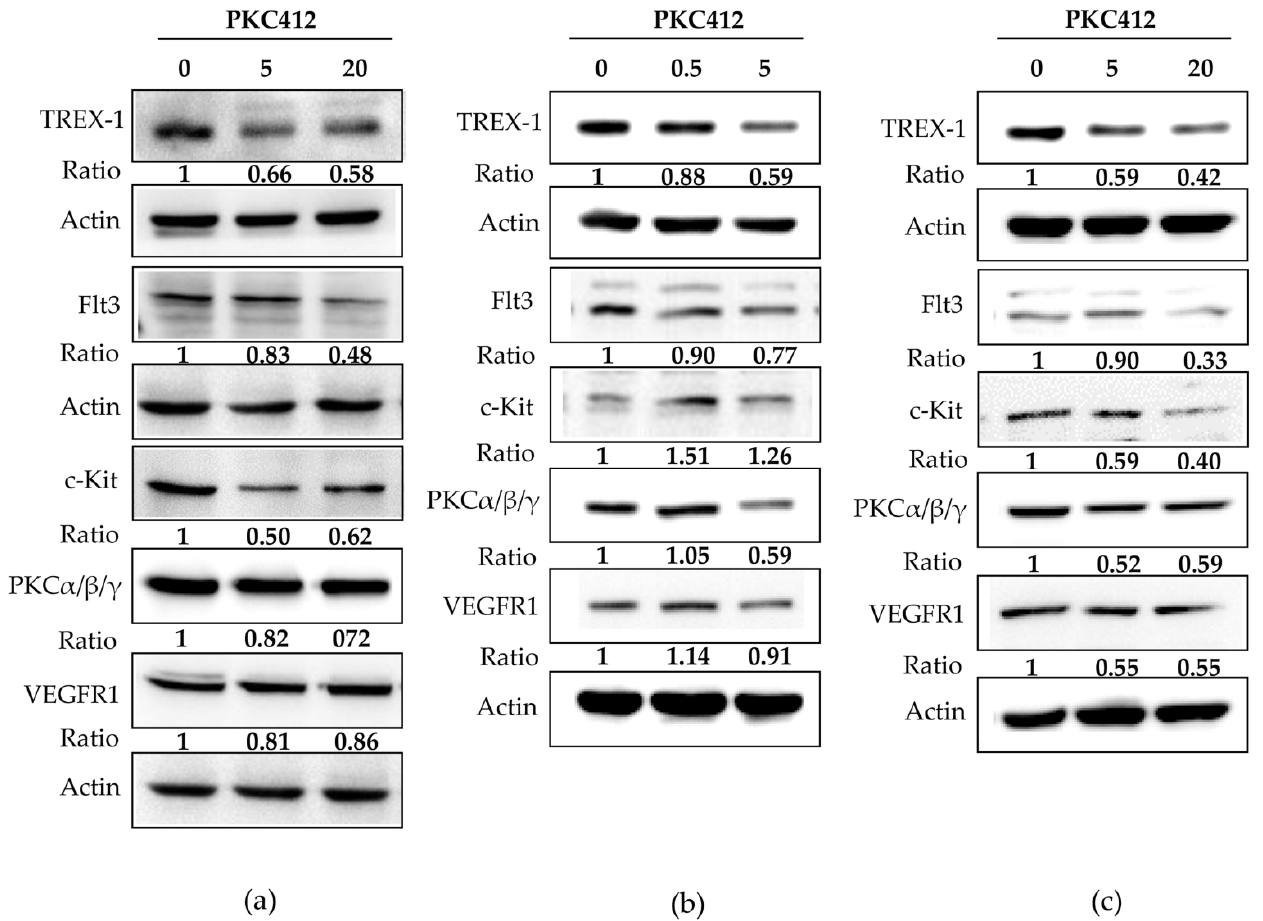
Figure 6. Effect of midostaurin (PKC412) on expression of putative target proteins in CT26 ( a ), HCT116 ( b ), and SW480 ( c ). Cells were treated with PKC412 for 24 h and then cells were lysed and harvested. Equal amounts of proteins were subjected to immunoblotting to detect midostaurin targets and Trex-1 proteins. Representative blots of midostaurin target proteins were shown. The densitometric analysis of each band was shown in the bottom panel. Original Western Blot images can be found in Figure S1.